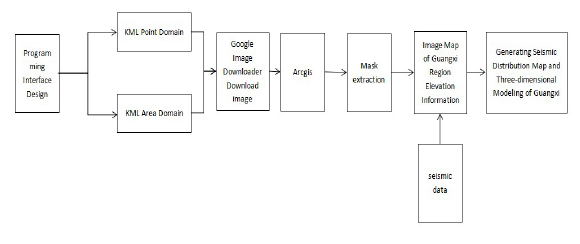
Figure 1. flow chart